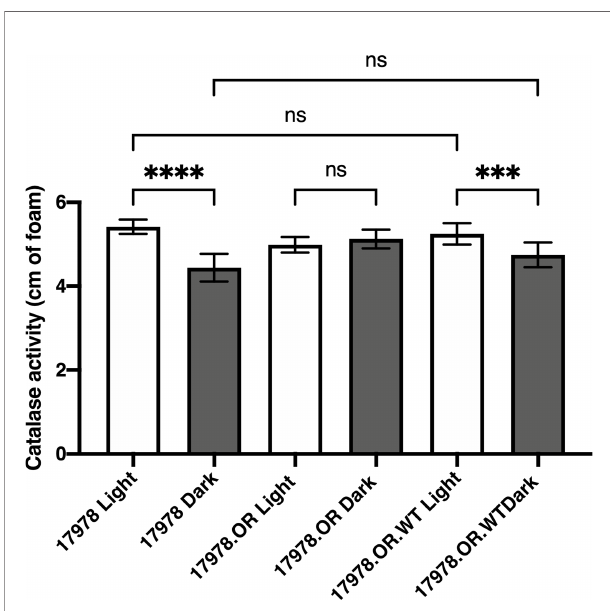
FIGURE 1 | Light- and BlsA-dependence of catalase activity. Catalase activity of the wildtype 17978 strain, the isogenic OR blsA - mutant (17978.OR), and the isogenic blsA - mutant complemented with a pMU368 derivative encoding wildtype BlsA (17978.OR.WT) was measured using culture samples representing equal numbers of bacteria that had been grown in SB under blue light or in darkness with shaking to exponential phase at 24° C. The catalase activity of each strain was analyzed using three independent biological replicates in technical triplicate ( n = 9). Error bars represent the standard deviations of the data sets. Horizontal bars with symbols indicate results of ordinary one-way ANOVA with Sidak ’ s multiple comparisons post- hoc test (*** P ≤ 0.001; **** P ≤ 0.0001; ns, not signi fi cantly different).